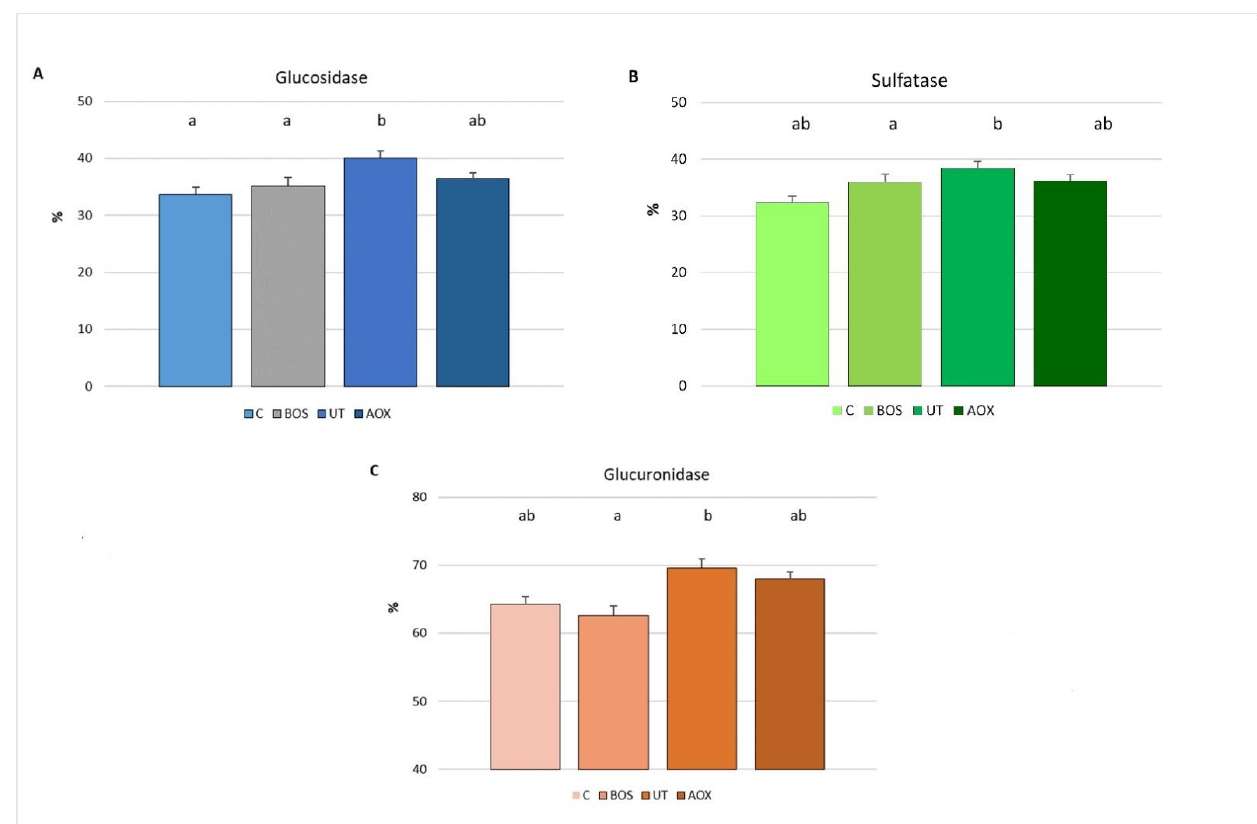
Figure 3. Piglets ’ blood antioxidant reserves in relation to dietary treatments, expressed as percentage of KRL value of whole blood released by enzymes (( A ) hydrolysis with glucosidase; ( B ) hydrolysis with sulfatase and ( C ) hydrolysis with glucuronidase). Data are reported as mean ± SEM; n = 16. C, control group; BOS, diet supplemented with B. serrata extract; UT, diet supplemented with U. tomentosa and T. parthenium extracts; AOX, diet supplemented with antioxidant plant extract mixture. a,b Means with different superscripts differ ( p < 0.05).